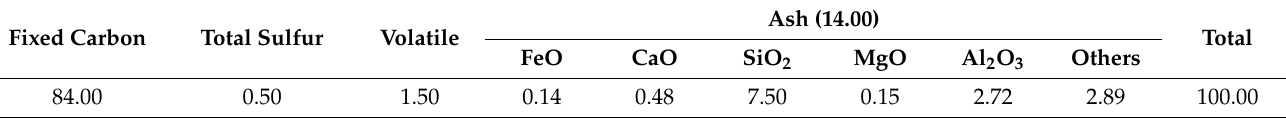
Table 2. Proximate analysis of the coke breeze and the chemical compositions of ash (mass fraction, %). Fixed Carbon Total